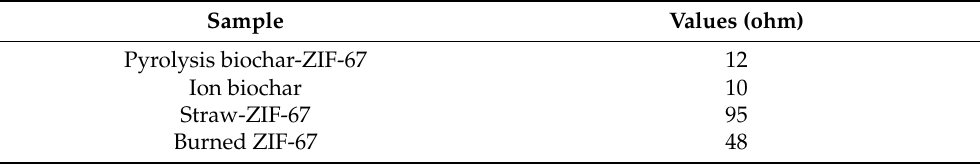
Table 1. Values of the C impedance diagrams for different